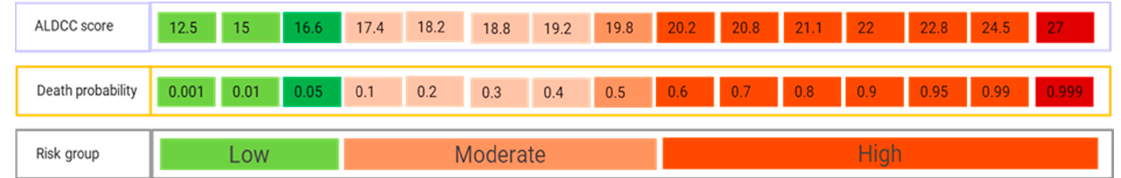
Figure 6. ALDCC score from nomogram and corresponding death probability of COVID-19 and non-COVID-19 patients where ALDCC score ≤ 16.6 and death probability ≤ 5% are shown for low risk group and ALDCC score > 19.8 and death probability > 50% are shown for high risk group.